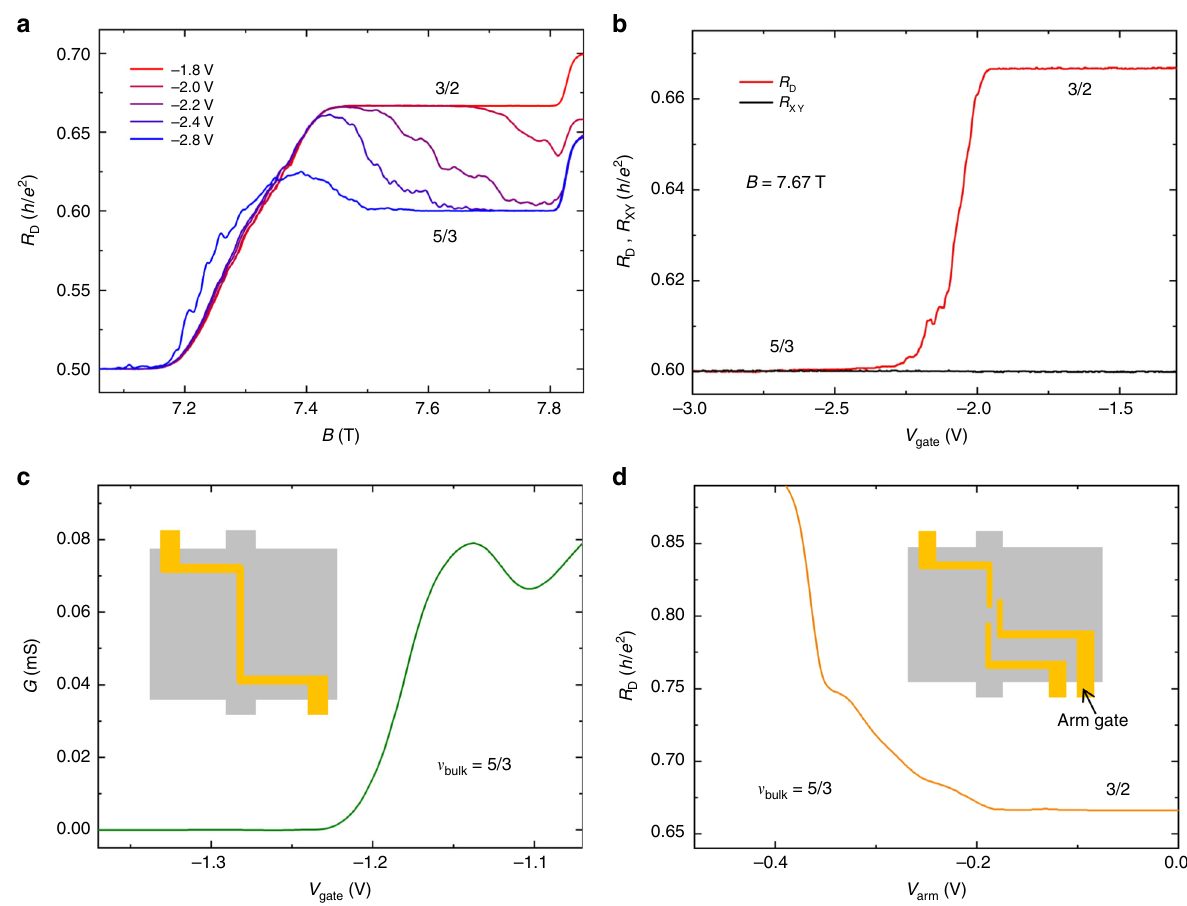
Fig. 3 Gate voltage dependence of the diagonal resistance, the Hall resistance and the two-terminal conductance. a Magnetic fi eld dependence of the diagonal resistance with different gate voltages. b Gate voltage dependence of the diagonal resistance and the Hall resistance at 7.67 T. The gate voltage was changed from − 1.3 V to − 3.0 V. c Gate voltage dependence of the two-terminal conductance across the single top gate. The gate was annealed at − 4.5 V. The conductance was measured at bulk fi lling factor 5/3. The measurement was carried out by applying a voltage excitation to the source contact and measuring the current from drain contact at the other side of the mesa. The inset is the sketch of the device and the device was made from the same wafer as that used in a . The minimum width of the top gate is 1.5 μ m, the same width as that of the gates used in one sample, with which the 3/2 plateau is observed (Supplementary Fig. 2). d Arm gate voltage ( V arm ) dependence of the diagonal resistance at bulk fi lling factor 5/3. The con fi nement gates were annealed at − 4.5 V. The arm gate was not annealed. During the measurement the con fi nement gates were kept at − 1.3 V. The inset is the sketch of the device and the device was made from the same wafer as that used in a . The dimension of the con fi nement is 1 × 2 μ m 2 . All these measurements